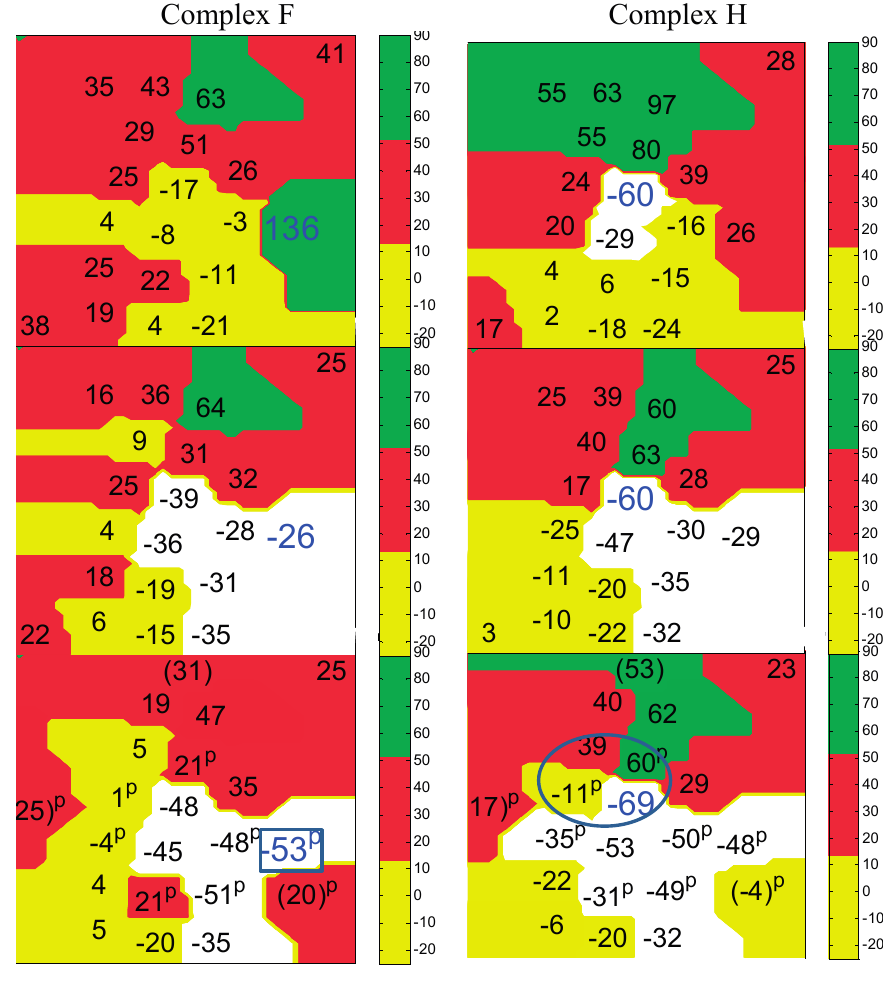
Figure 2. 3-D maps displaying endocardial ( lowest panel ) midwall ( middle panel ) and epicardial ( top panel ) site activation times (ms) before (-) and after onset of surface QRS for VT-F ( top left ), VT-H ( top right ). VT-L ( bottom left ) and VT-O bottom right ). Numerical times can be compared with activation positions labeled “f, h, l and o” on Figure 1a–c. As shown in the vertical bar on the right of each layer, yellow indicates early sites ( − 25 to 15), red indicates intermediate sites and green indicates late sites. White indicates activation earlier than − 25. “p” marks a Purkinje recorded site. Note the focal activation of VT-F on endocardium (–53) in white area, enclosed by blue rectangle. VT-H is reentrant on endocardium with − 69 ms and subsequent activation thru that layer at − 11, 39 and 60 ms, enclosed by the blue oval. VT-L shows reentry on endocardium at − 38 with subsequent activation thru that layer at 21 and 105 ms, enclosed by blue oval. VT-O is epicardial focal (blue square in yellow area). This series of maps shows the complexity of induced VT/F in this ischemic